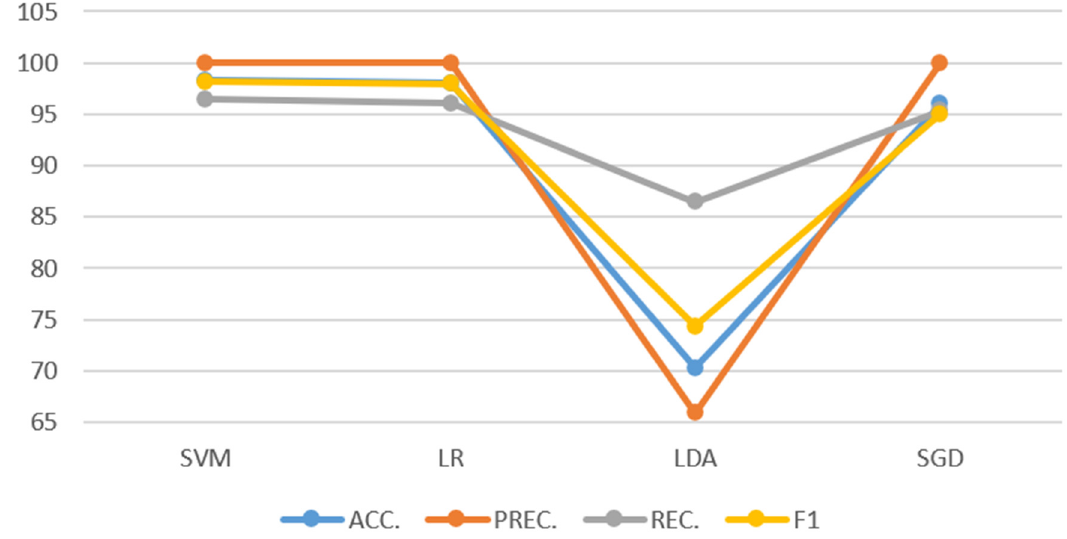
Figure 10. Performance of classifiers on InceptionV3 features.